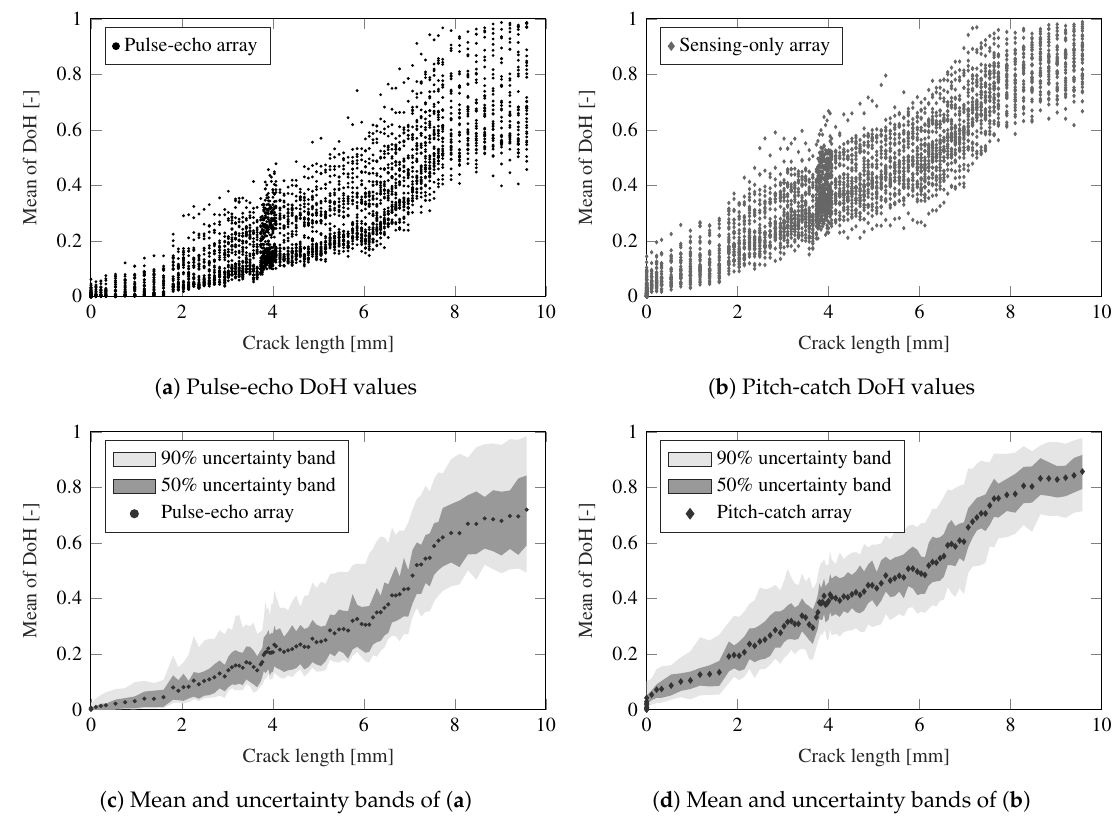
Figure 9. Relationship between crack growth and mean of DoH for both pulse-echo and pitch-catch working modes. Panels ( a , b ) provide the data for the 37 directions with an average value of DoH with respect to the PWAS in the array. Additionally, ( c , d ) show the mean and 90% and 50% uncertainty bands of the DoH